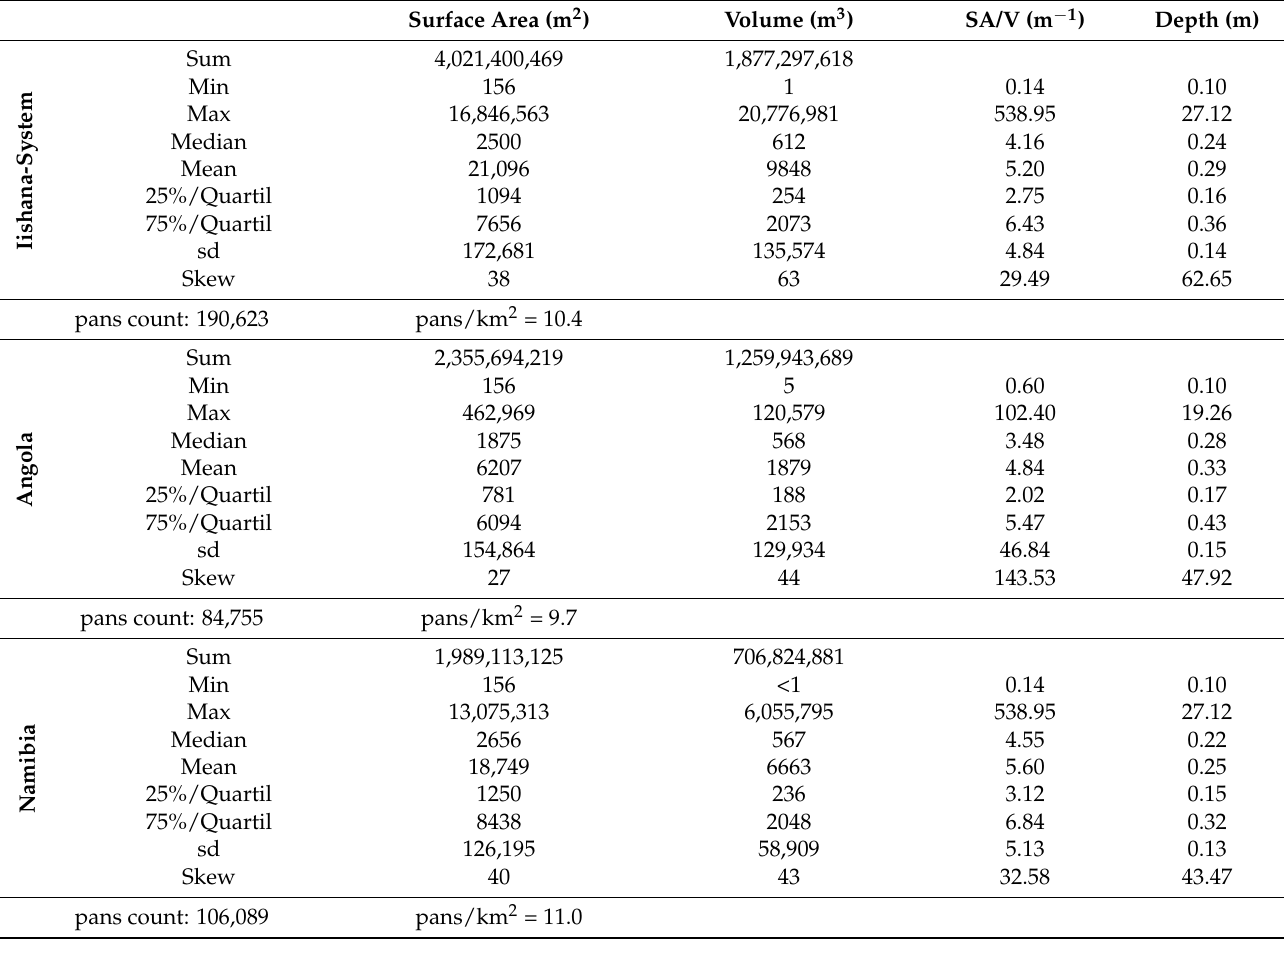
Table 1. Pan statistics listed by region: total Iishana-System, Namibian territory, and Angolan territory.